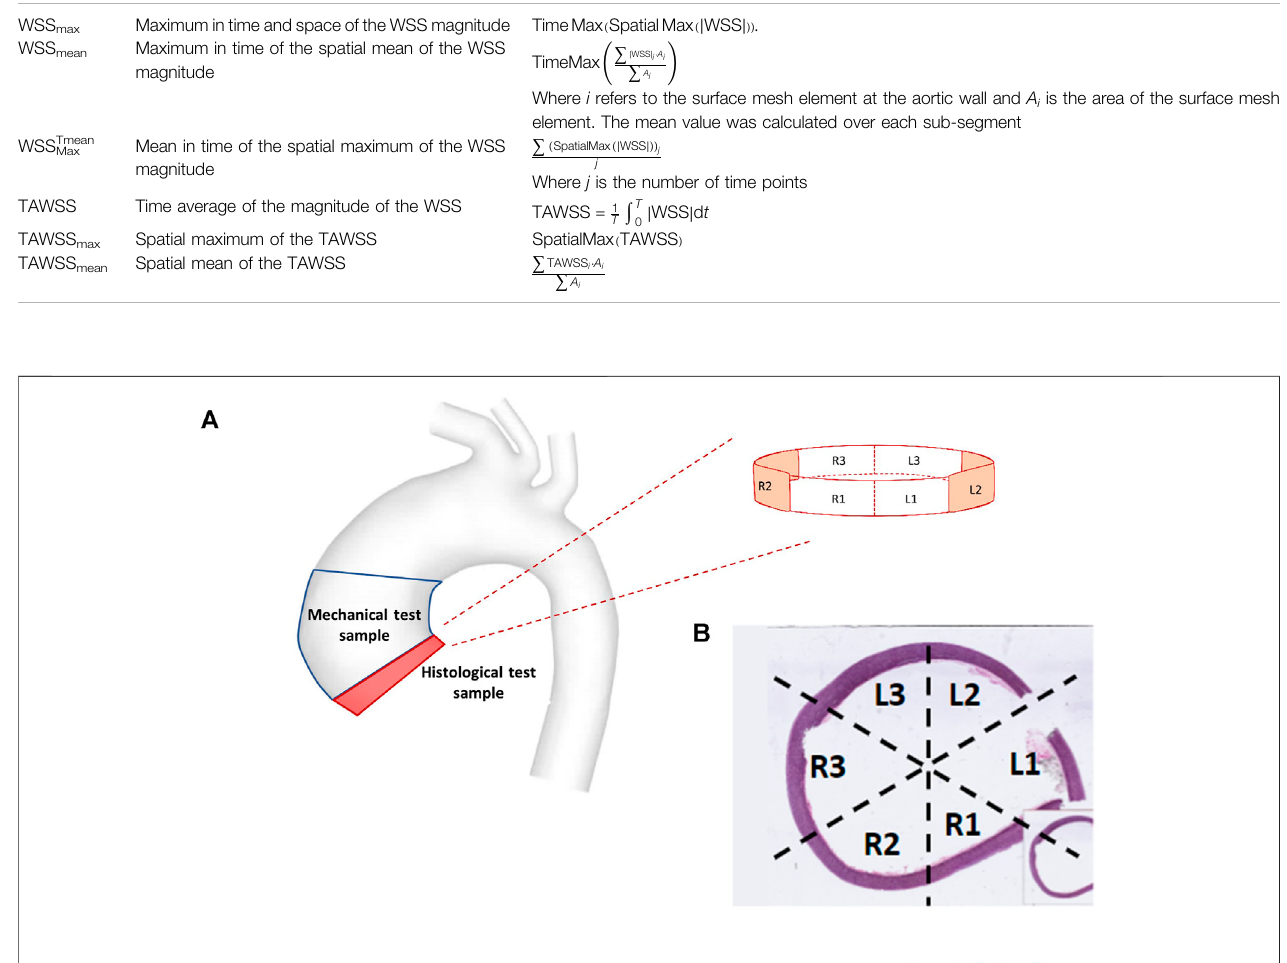
TABLE 1 | Calculated wall shear stress (WSS) parameters from computational fl uid dynamics (CFD) analysis. Short name